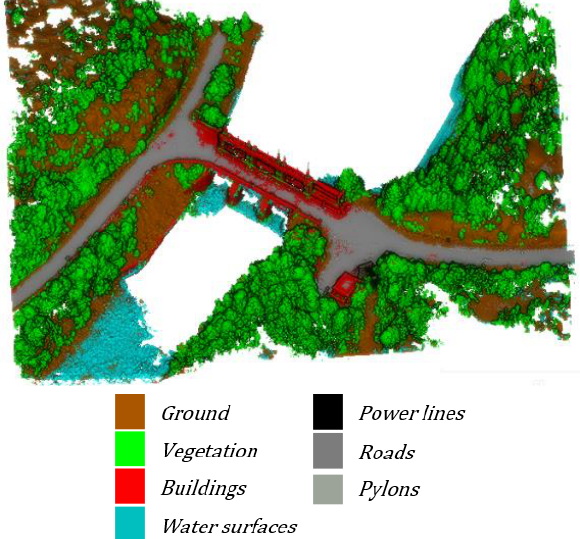
Table 8. Mean metrics for different point clouds.